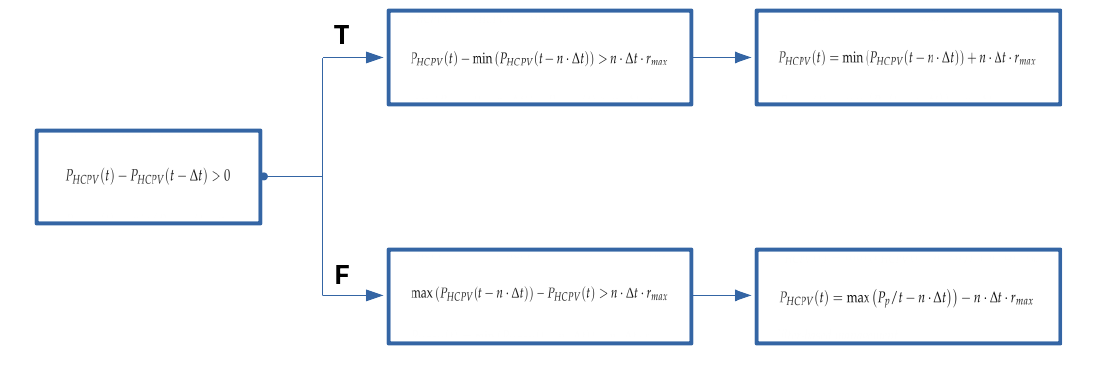
Figure 7. Flowchart of the step-rate control